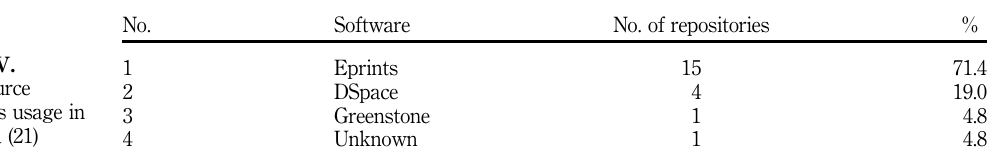
Table III. Softwares used in Asian repositories (609)